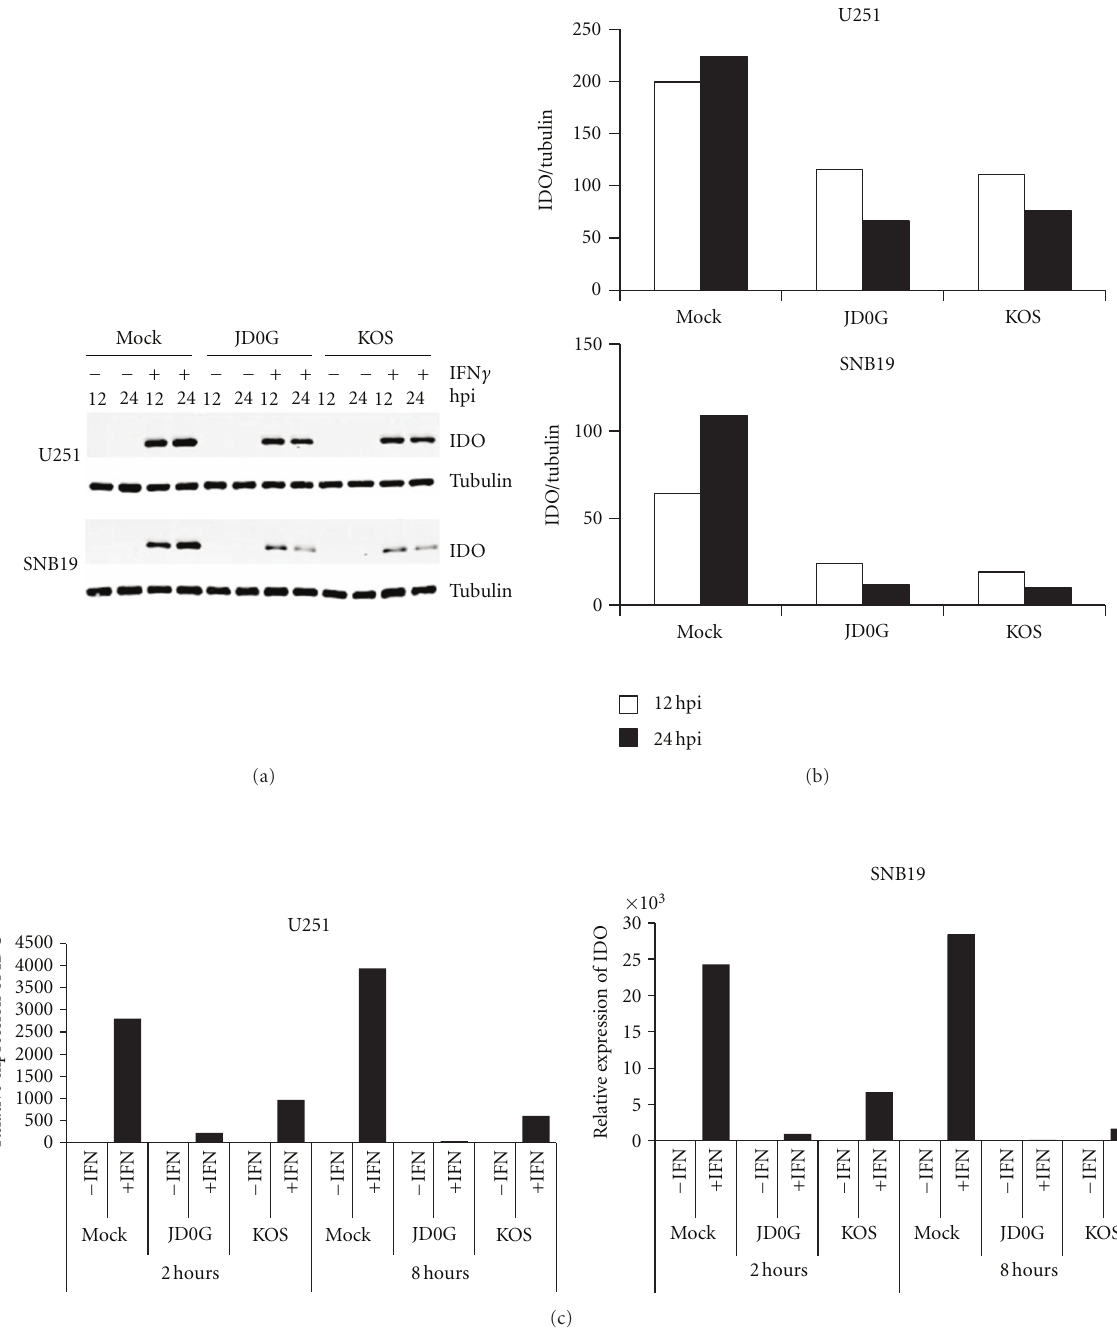
Figure 5: Reduction in IFN γ -induced IDO expression following virus infection of glioblastoma cells. (a) The e ff ect of virus infection on IFN γ -induced IDO protein levels in SNB19 cells (top) and U251 cells (bottom) was visualized by Western blot. Cells were treated with IFN γ or mock treated for 24 h prior to infection with either JD0G or KOS virus. At 12 and 24hpi, cell lysates were analyzed by Western blot with antibodies against IDO protein (upper panels) or α -tubulin (lower panels). (b) IDO protein levels were quantified using the Odyssey Infrared Imaging System, and the relative amount of IDO protein (IDO/ α -tubulin) in each sample is shown. Data are representative of three experiments using di ff erent time points. (c) The e ff ect of virus infection on IDO mRNA levels in SNB19 and U251 cells was assessed by quantitative RT-PCR. Cells were treated with IFN γ or mock treated for 24 h prior to infection with either JD0G or KOS virus, and total cellular RNA was collected at 2 and 8 hpi. IDO mRNA levels for each sample were normalized to GAPDH levels and the fold change in IDO expression for each sample is shown relative to the untreated, mock-infected